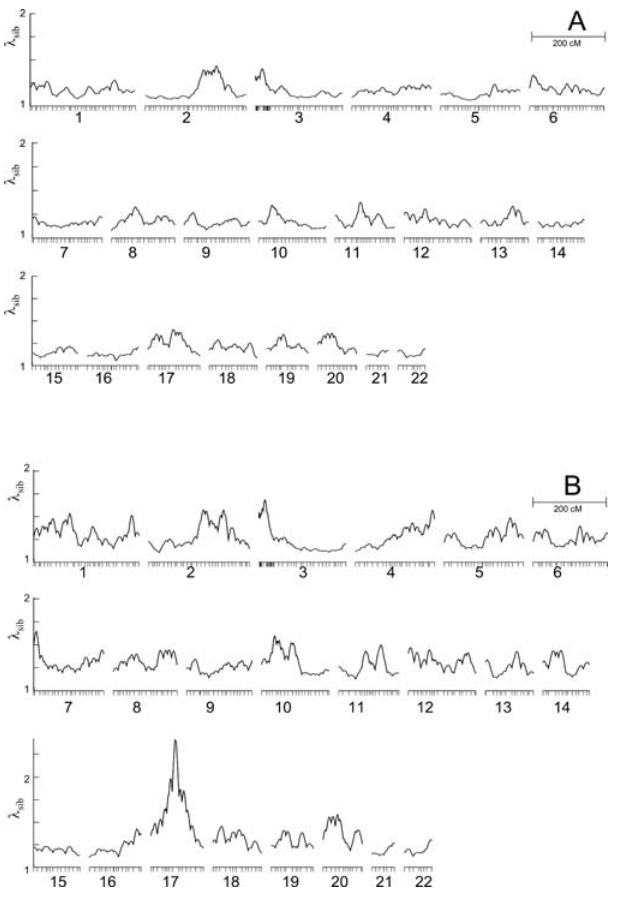
Figure 3. Exclusion Linkage